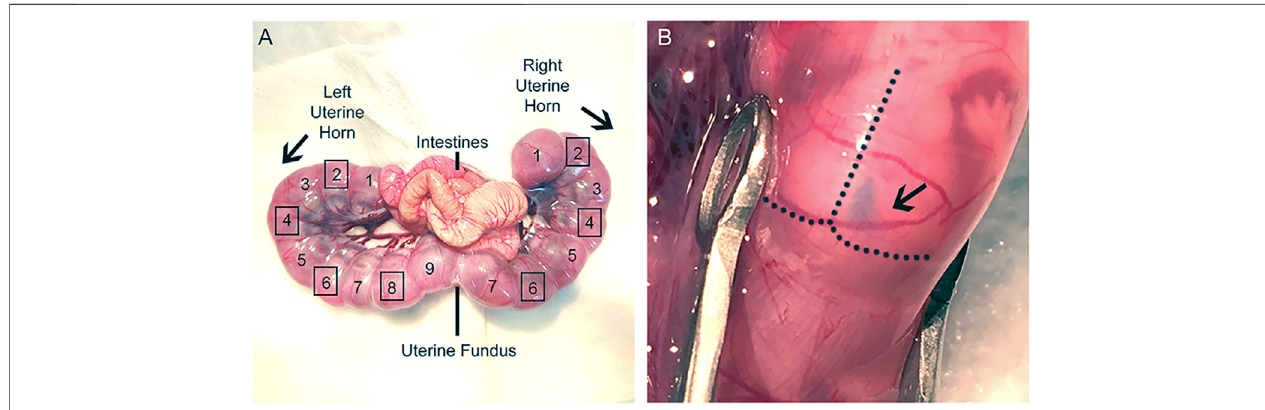
FIGURE3| UterinehornsexposureduringIUEsurgery. (A) :ImageofdissecteduterinehornsandlabelingofdesiredIUEembryos.Uterinefundusisausefulmarker todistinguishthetwouterinehornsandcanbeusedasareferencetoidentifytheelectroporatedembryospriortothesecondIUE.Labelembryosbeginningattheuterine knots and continue sequentially to the uterine fundus for each uterine horn. Do not electroporate the embryos at the uterine knot or at the fundus (Left horn: 1, 9; Right horn:1,7).SquaressurroundingthenumberedembryosdenotewhichembryosshouldreceiveIUE(Lefthorn:2,4,6,8;Righthorn:2,4,6).Electroporateembryos in an alternating fashion in the same hemisphere for both IUEs. (B) : Image of lateral ventricle injection. Plasmid DNA was injected into E15 embryo, and the right lateral ventricle was fi lled with fast